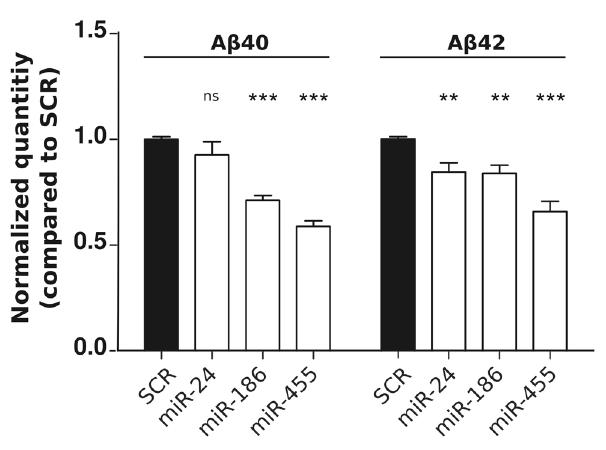
FIGURE 2 | miR-24, miR-186, and miR-455 expression results in decreasedA β secretion. Relative quantities of human A β 40 and A β 42 peptides measured by ELISA in the culture medium of HEK-APPSwe cells after transfection with 50 nM pre-miRNAs (as indicated). Signals were normalized to the basal A β secretion found in cells transfected with SCR miRNAs. Statistical significance was assessed by one-way ANOVA with Bonferroni post-hoc test. * p < 0.05, ** p < 0.01, *** p <